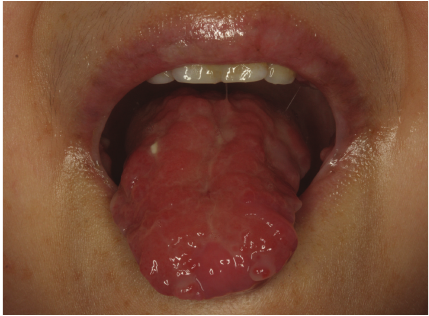
Figure 4: Soft tissue distortion in a patient with chronic